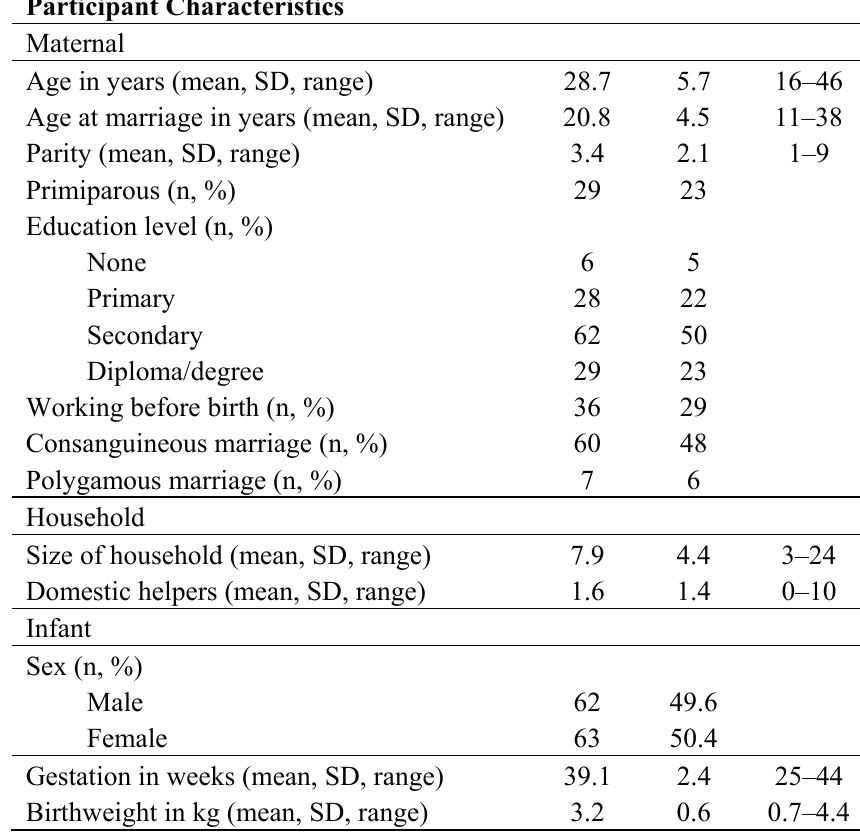
Table 1. Characteristics of mothers &